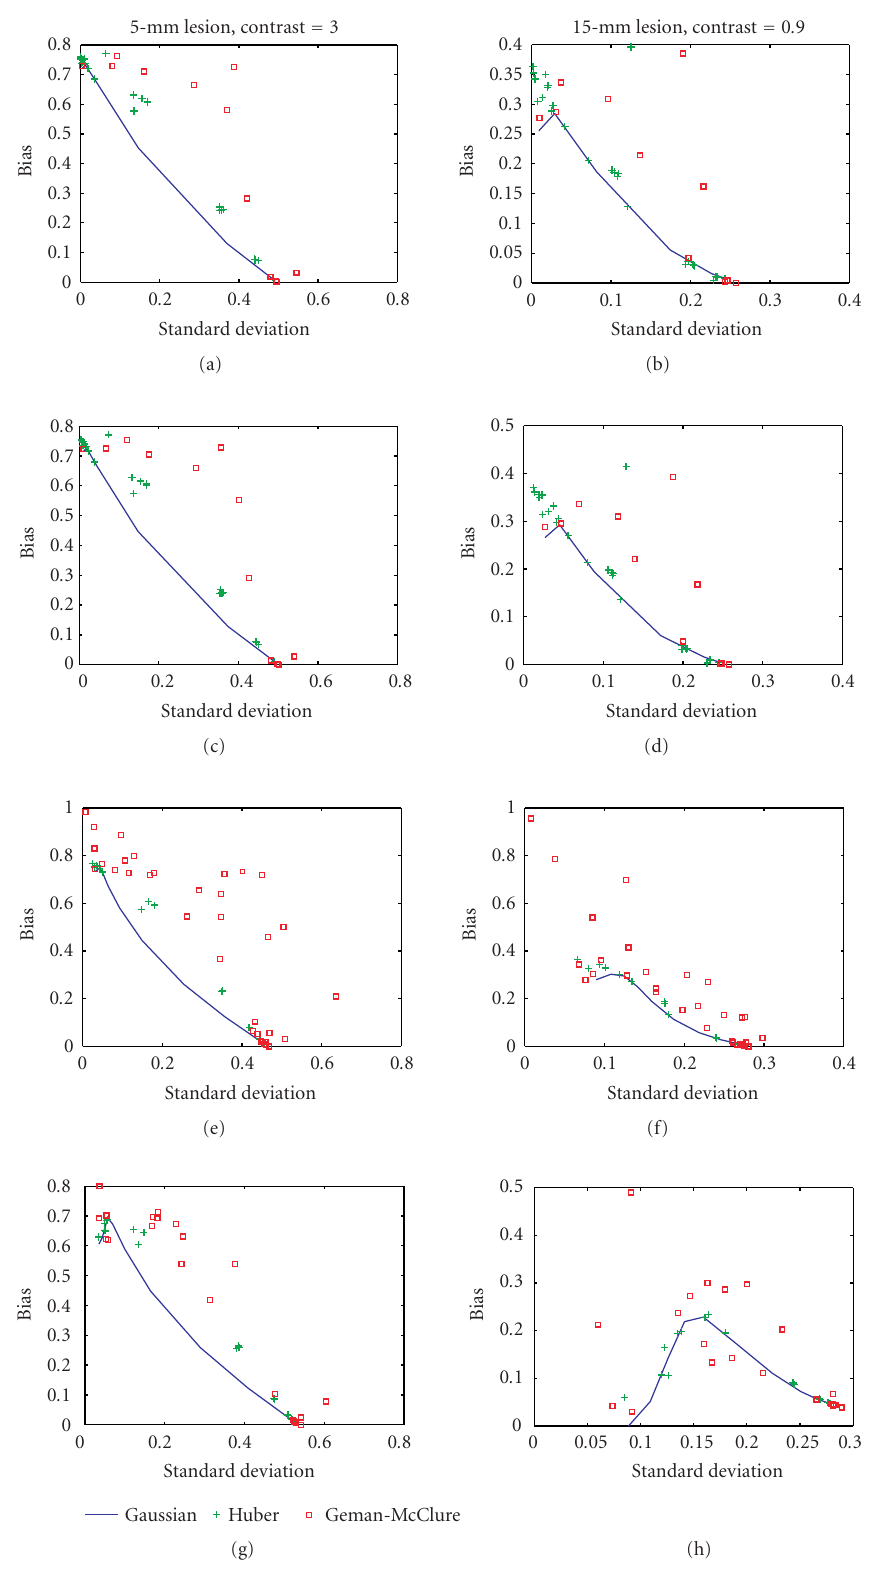
Figure 8: The bias versus standard deviation tradeo ff for quantification of total uptake of a tumor in di ff erent backgrounds. (a) and (b) Fixed uniform background; (c) and (d) lumpy backgrounds in Figure 3(b); (e) and (f) lumpy backgrounds in Figure 3(c); and (g) and (h) lumpy backgrounds in Figure